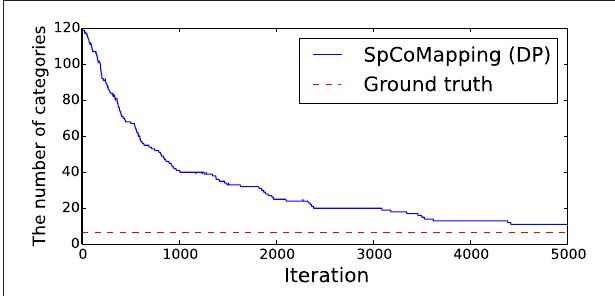
FIGURE 6 | Example of the changes in the number of categories by iteration on the proposed method (Room1ldk4).